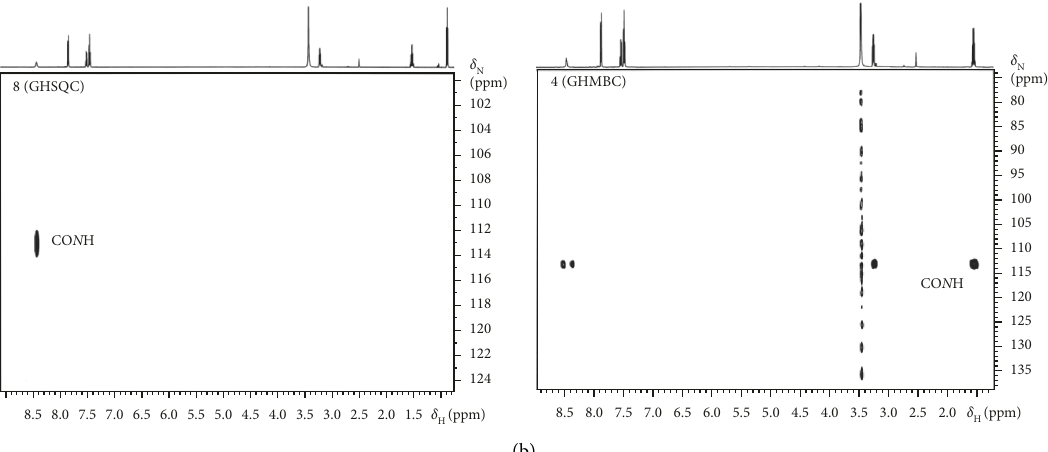
Figure 3: Gradient-enhanced 1 H- 15 N correlation spectra of 2 , 4 , 7 , and 8 showing the connectivity between the carbamoyl and ammonium groups. The appropriate proton spectra are plotted atop the contour plot to provide a better representation of the position of all the nitrogen